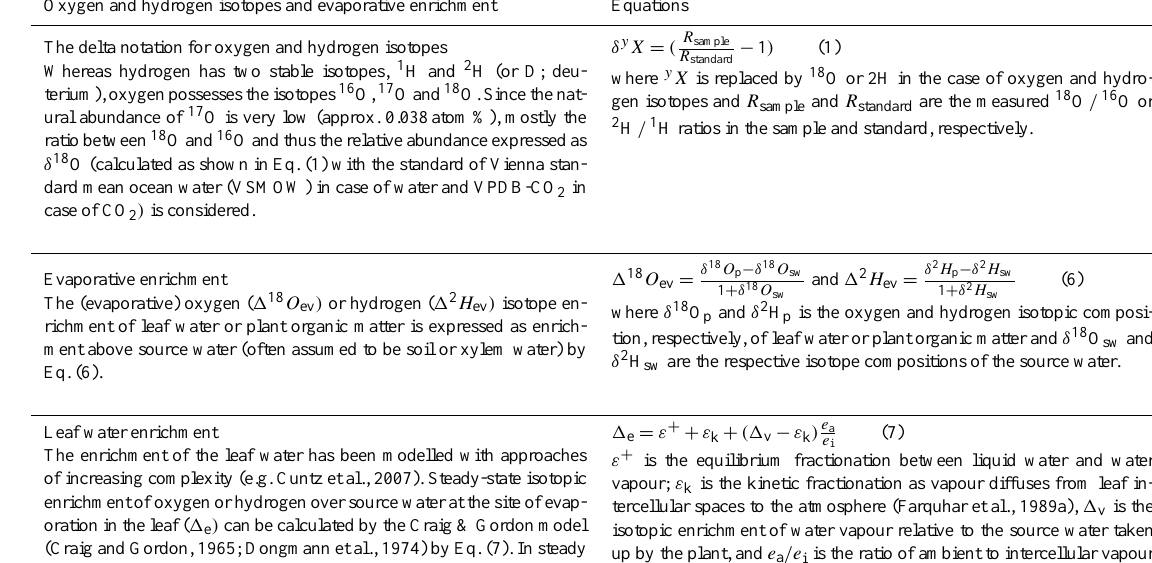
Table 2. Introduction to terms and equations of oxygen and hydrogen isotopes and evaporative enrichment. Oxygen and hydrogen isotopes and evaporative